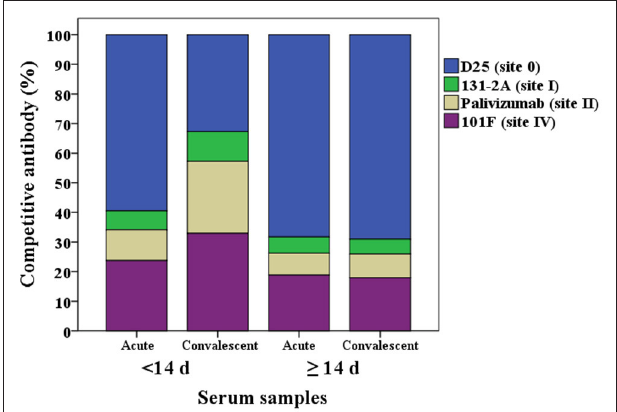
FIGURE 3 | Percentage of each RSV antigenic site-specific competitive antibody GMC ( µ g/mL) to the total GMC ( µ g/mL) for acute and convalescent sera from HCT adults shedding virus < 14 days and ≥ 14 days. The Y axis is the percentage of each competitive antibody GMC to the total GMC. The X axis is the serum types: acute or convalescent sera from HCT adults shedding virus < 14 days or ≥ 14 days. The total GMC was the sum of 4 competitive antibody GMC. The percentage of each competitive antibody was that the competitive antibody GMC divided by the total GMC. GMC, geometric mean concentration. N = 40 in each competitive antibody assay.